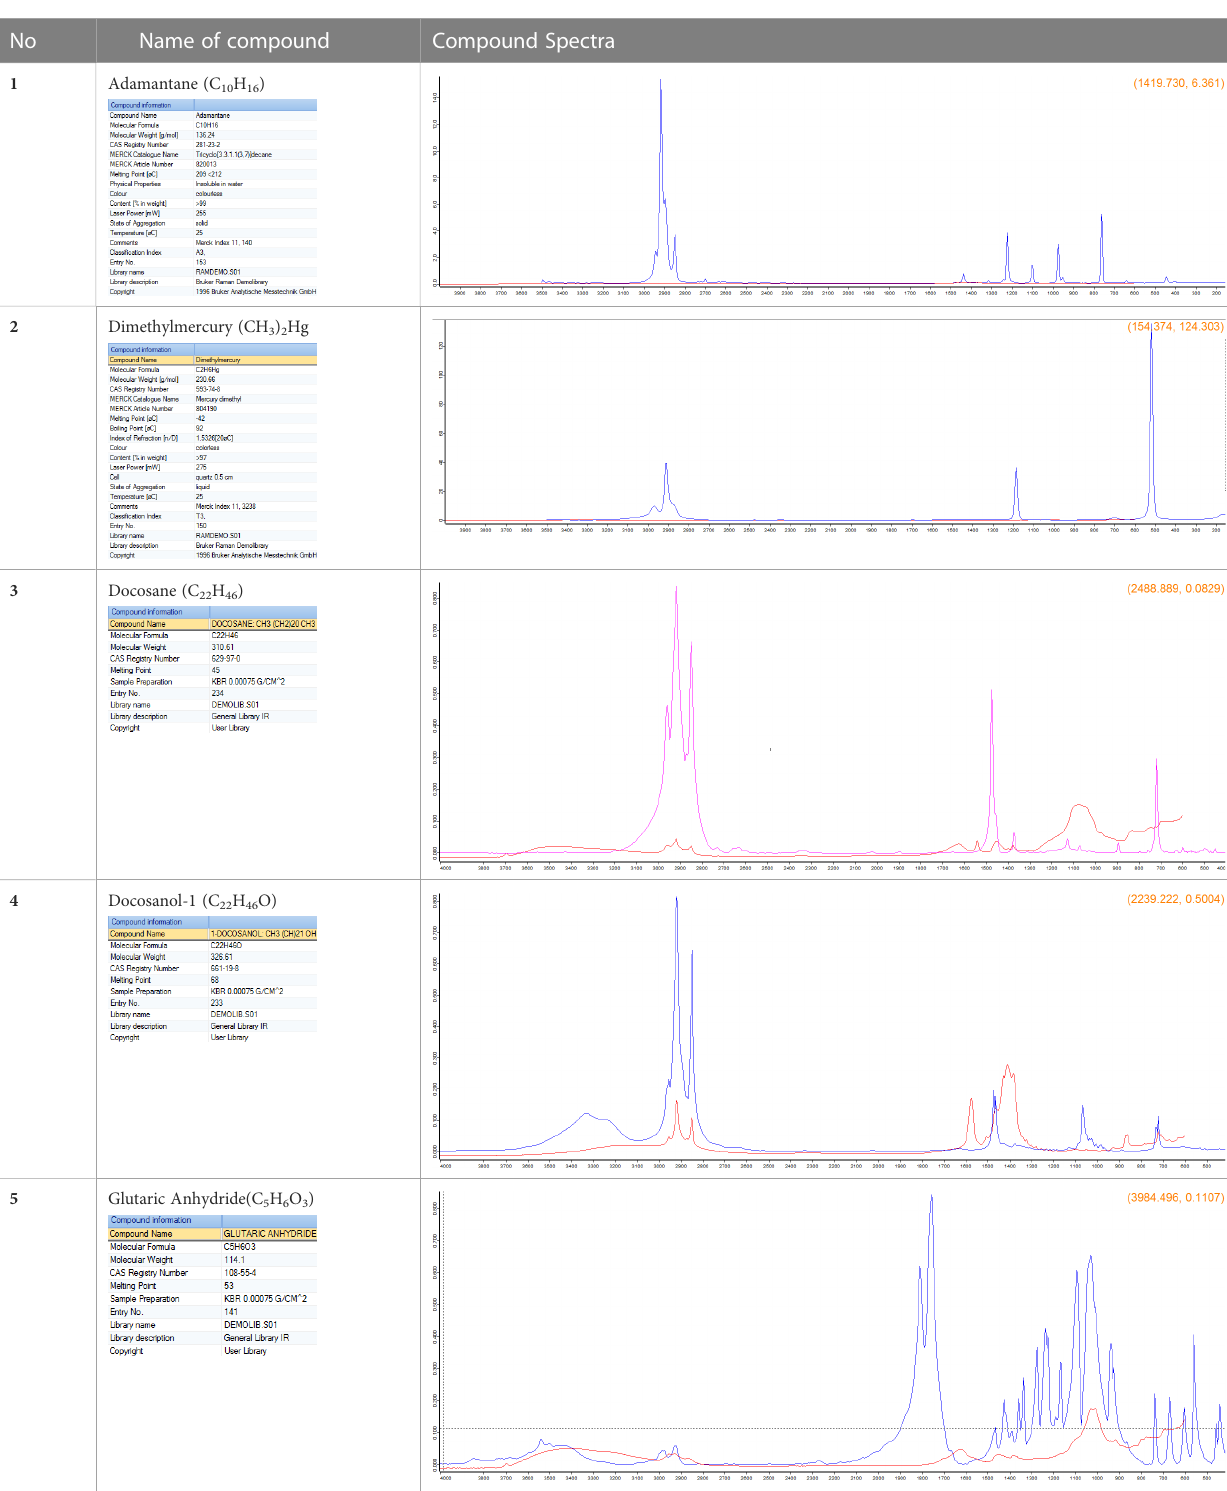
TABLE 5 List of the chemical compounds found in MP